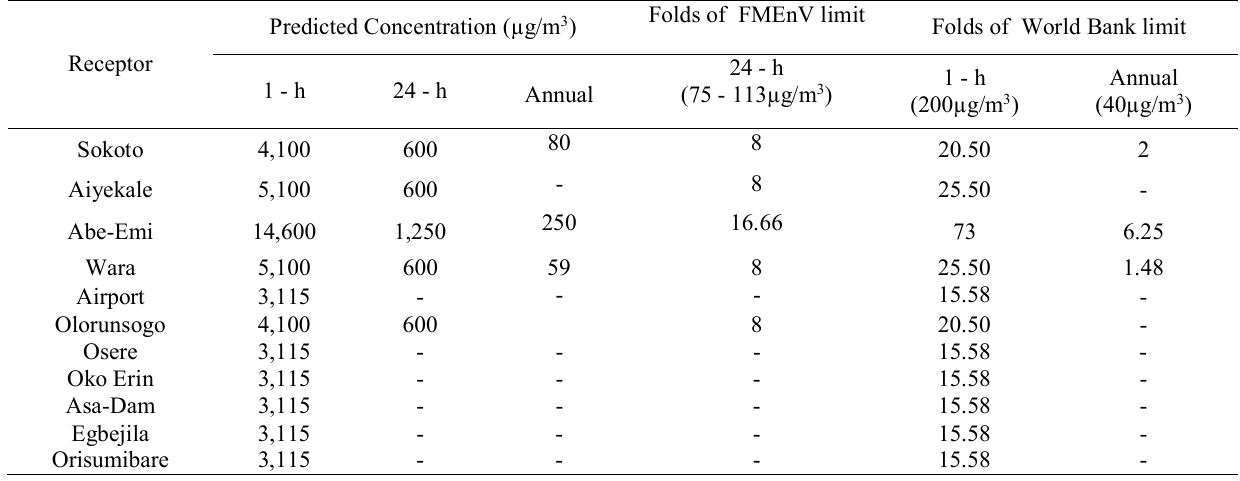
Table 4. Predicted cumulative impacts of NO X around Sokoto-Aiyekale dump site.